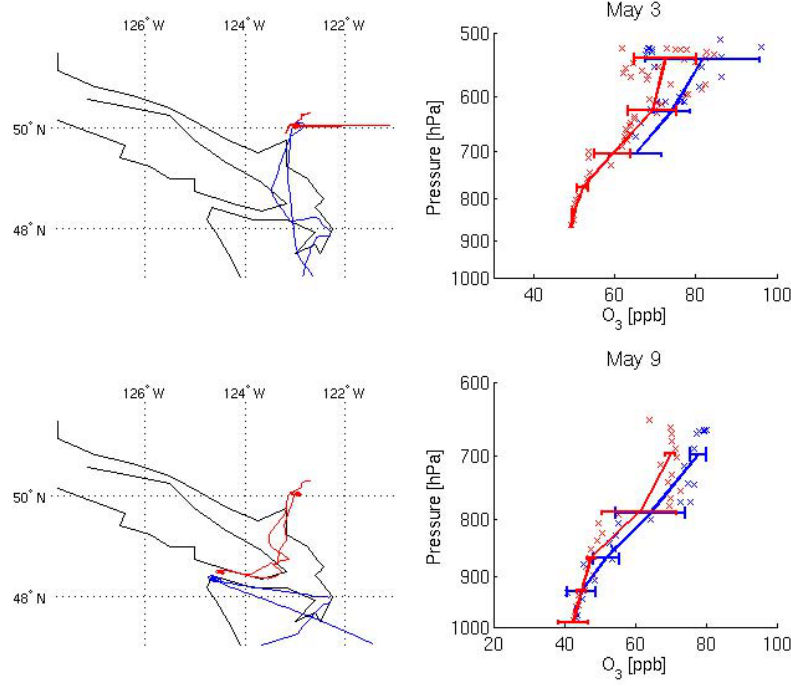
Fig. 2. Flight tracks and vertical mean profiles of ozone measurements during the two intercomparison flights between the C-130 (shown in blue) and the Cessna (in red). Top panels show the May 3 flights; bottom panels show the May 9 flights. Crosses indicate 1-minute mean measured values of ozone on each platform. Data are filtered to include only points where the two platforms flew within 0 . 3 ◦ latitude and longitude of one